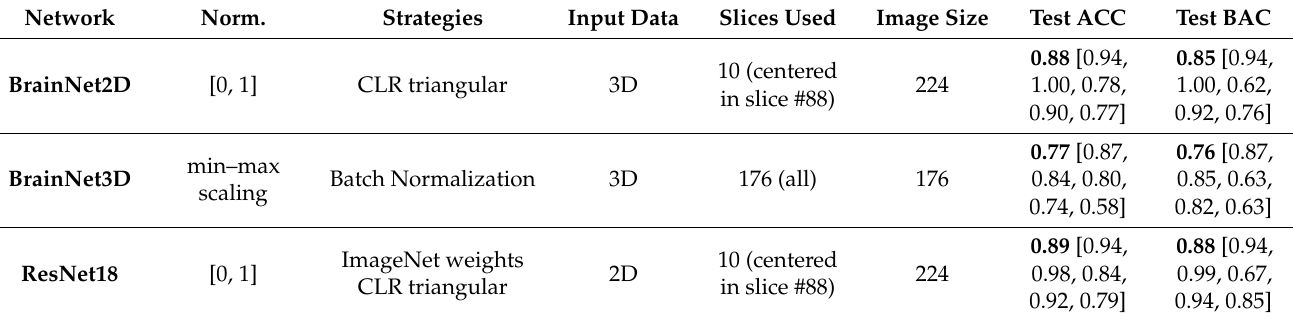
Table 4. Results for three-class classification, CDR = 0 (healthy), CDR = 0.5 (very mild stage) and CDR = 1, 2 (severe stage), over the OASIS-2 dataset.